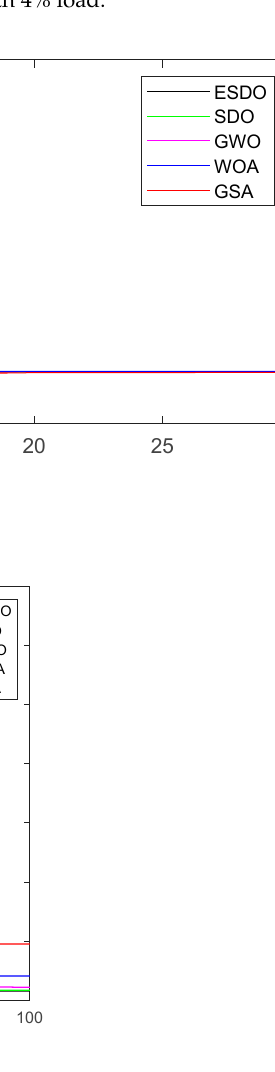
Figure 12. Convergence curves of average fitness with 8% load.